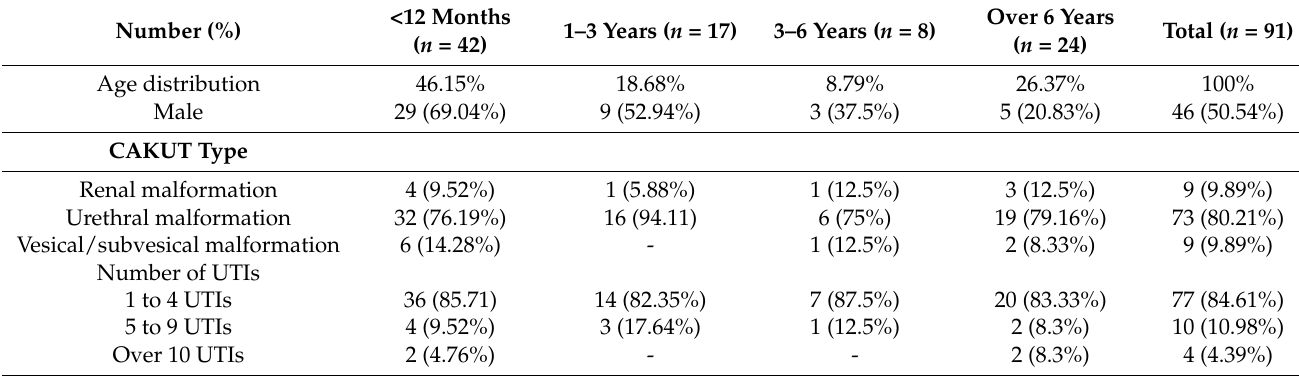
Table 1. Patient distribution in regard to age, sex, CAKUT type, and UTI